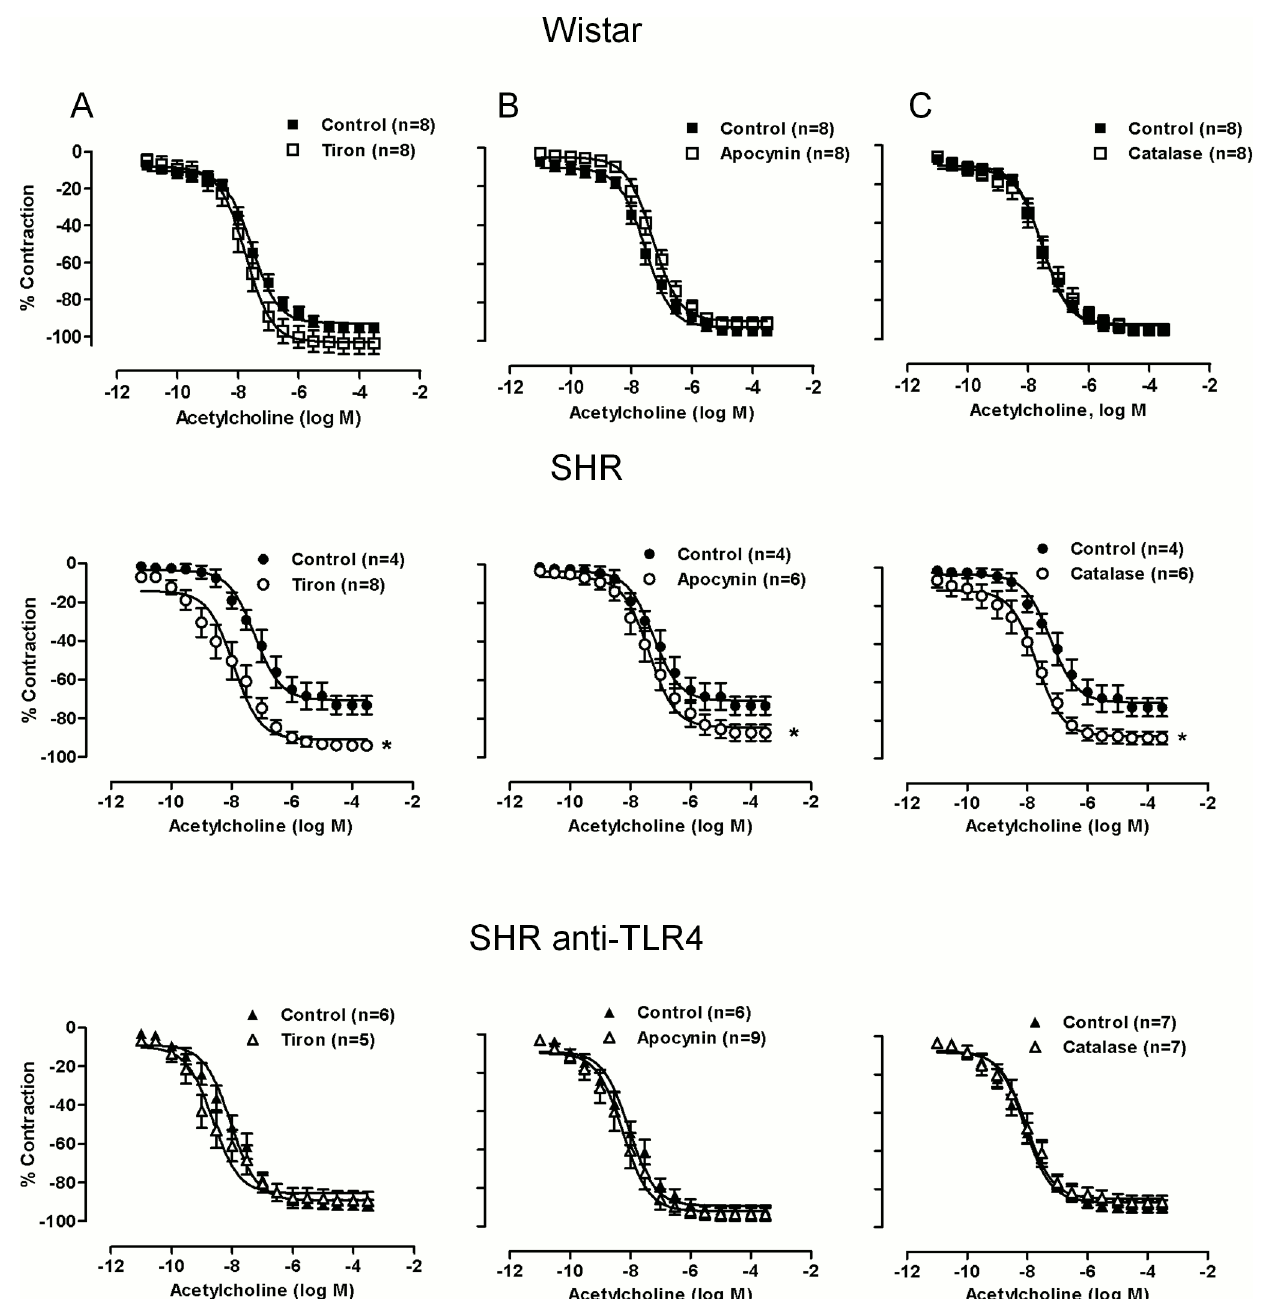
Figure 6. TLR4 inhibition abolishes the enhancing effect of antioxidants on acetylcholine-induced vasodilation. Concentration- response curves to acetylcholine in aortic segments Wistar and SHRs treated with a non-specific IgG (1 m g/day, 15 days) and SHRs treated with anti- TLR4 antibody (1 m g/day, 15 days) in the absence and presence of (A) tiron (1 m M), (B) apocynin (30 m M) and (C) catalase (1000 U/ml). Control curves were the same in the different situation of the three experimental groups. The results are the mean 6 SEM. *P , 0.05 vs. SHR using two-way ANOVA and Bonferroni post-test. The number of animals used is shown in parentheses. doi:10.1371/journal.pone.0104020.g006 the superoxide anion scavenger 4, 5-dihydroxy-1, 3-benzene- disulphonic acid (tiron, 1 m M) and the hydrogen peroxide detoxificant catalase (1000 U/ml). These drugs were administered 30 min prior to incubation with phenylephrine or acetylcholine. ester (L-NAME, 100 m M), was added for 45 min. The results of